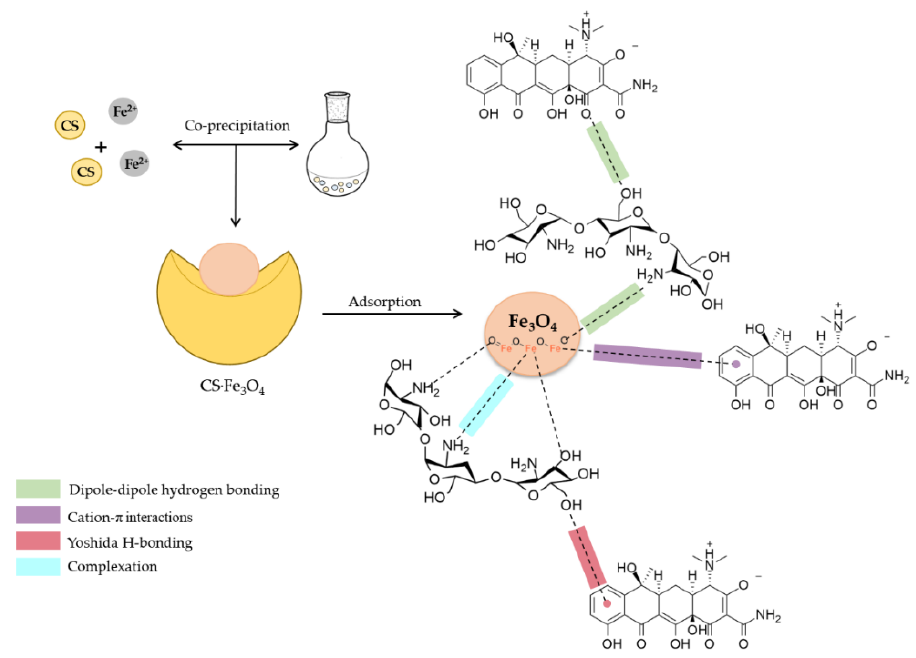
Figure 11. Hypotheses of the tetracycline adsorption